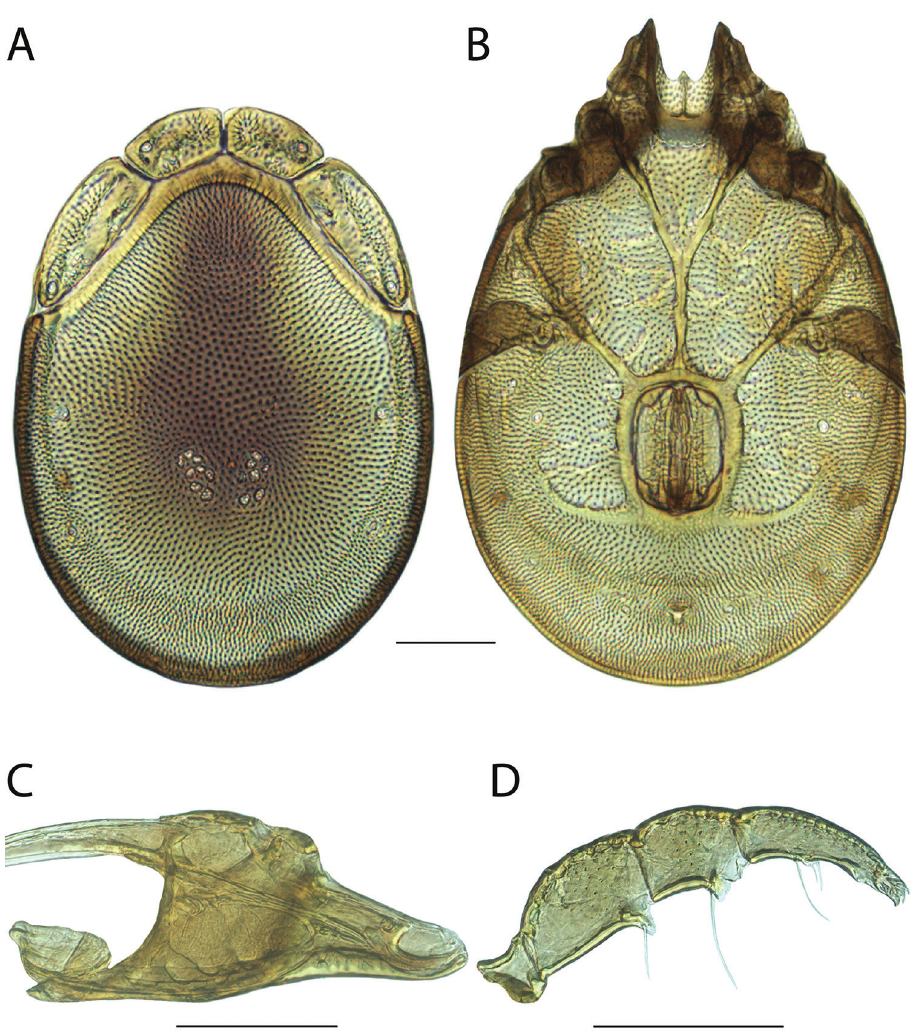
Figure 154. Torrenticola mohawk sp. n. male: A dorsal plates B venter (legs removed) C subcapitulum D pedipalp (setae not accurately depicted). Scale = 100